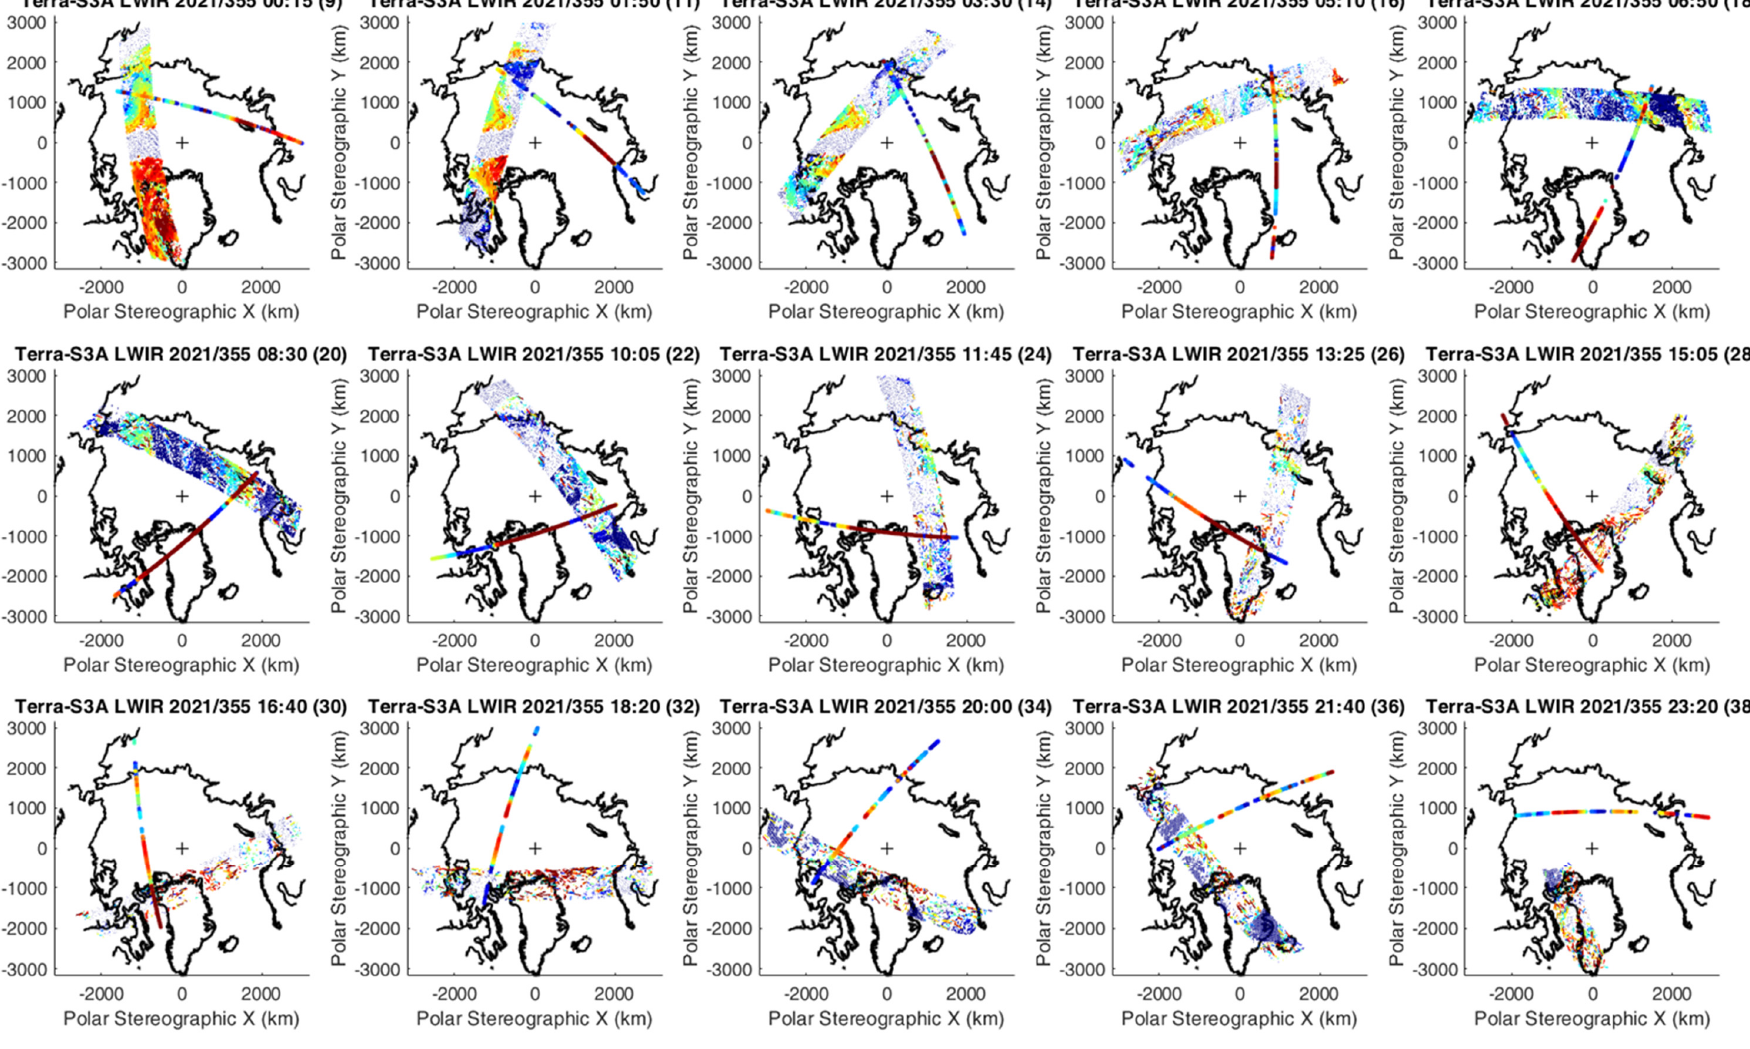
Figure A3. Terra and Sentinel-3A retrievals for North Polar winter (21 December 2021, LWIR).